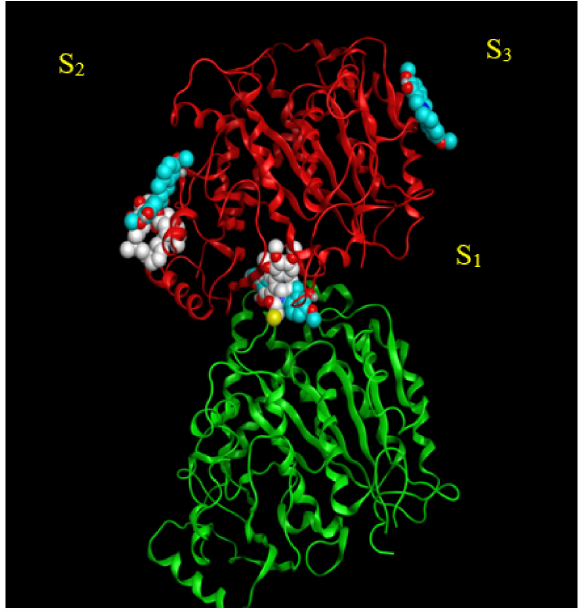
Figure 2. S 1 , S 2 , and S 3 represent the three predicted potential binding sites by blind docking of scoulerine (blue) to α (green) and β (red) tubulins of 1SA0 PDB structure. Colchicine derivative from 1SA0 in S 1 and laulimalide from 404H in S 2 are shown in